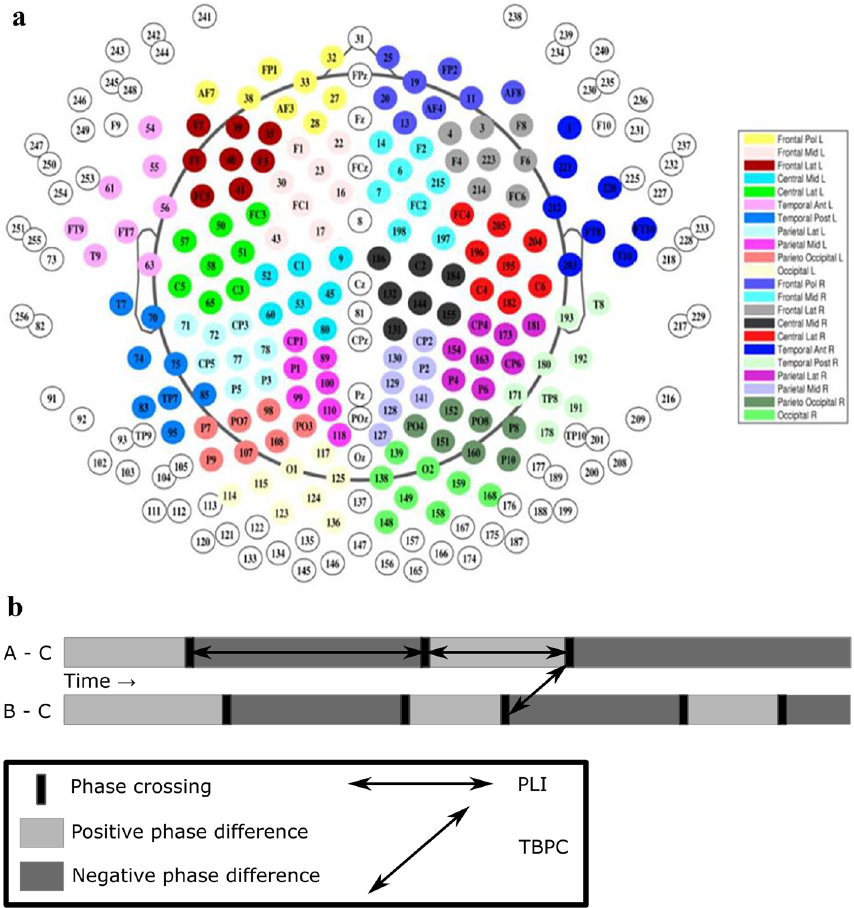
Figure 2. ( a ) 256-channel montage of EEG (only color-coded electrodes were analyzed). ( b ) Visual representation of the time course of phase differences between pairs of EEG signals. Each horizontal bar represents the phase differences between two EEG signals over time. Light and dark gray areas represent episodes with positive and negative phase differences, respectively. Vertical black bars mark transitions between positive and negative episodes (phase